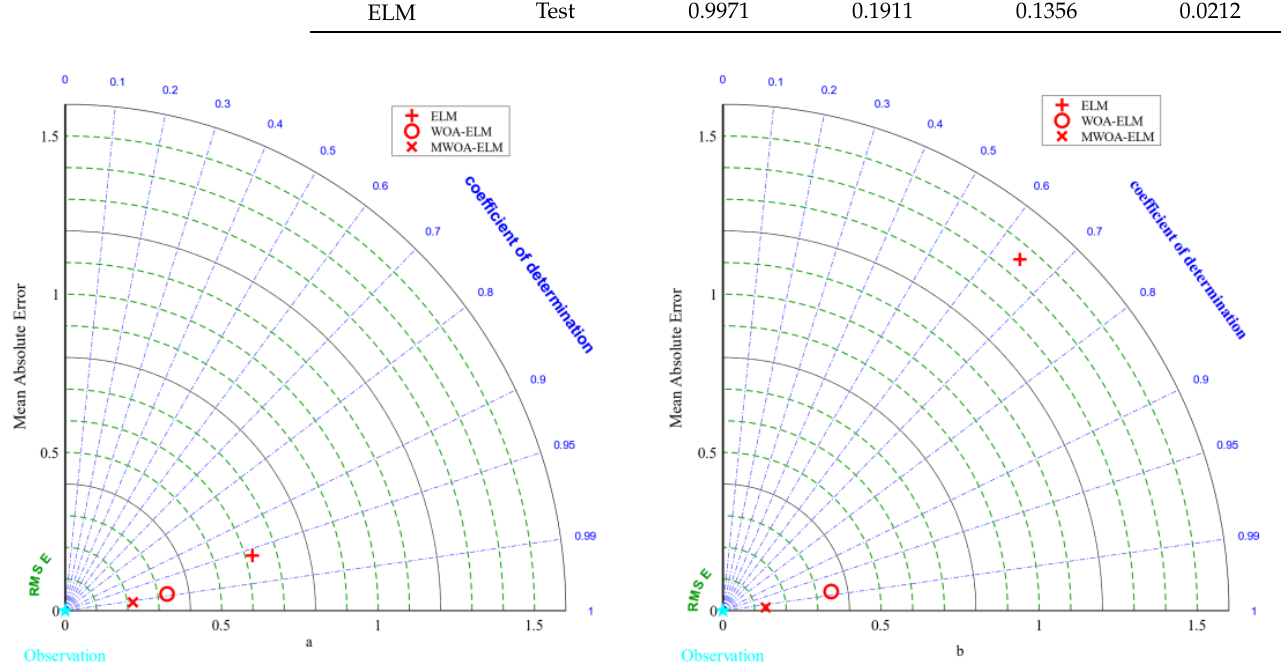
Figure 8. Taylor diagrams for the Training ( a ) and Testing ( b ) sets of the three ELM models. Table 3. Average of evaluation indicators for three ELM models.